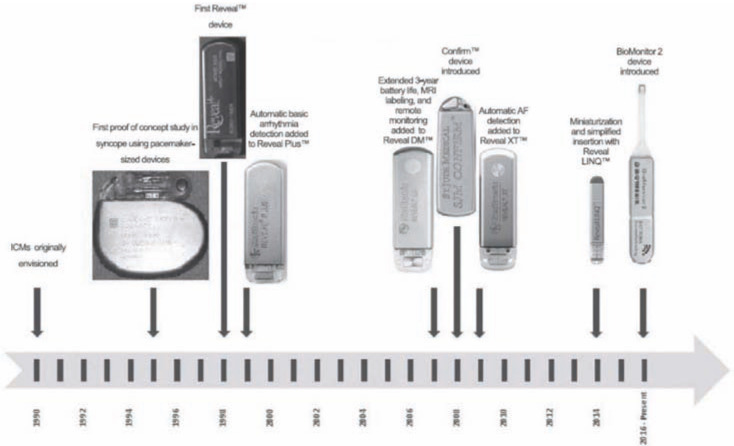
FDA-approved implantable/insertable cardiac monitors.20 Reprinted with permission from: Tomson TT, Passman R. Current and emerging uses of insertable cardiac monitors: evaluation of syncope and monitoring for atrial fibrillation. Cardiol Rev. 2017 Jan/Feb;25(1):22−29. http://insights.ovid.com/crossref?an=00045415-201701000-00007.